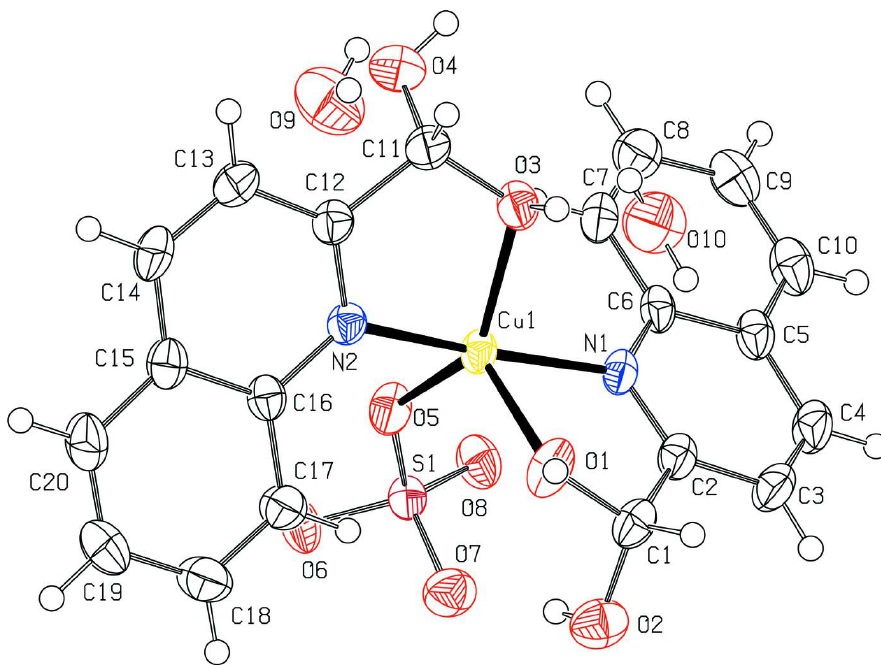
Figure 1 The molecular structure with displacement ellipsoids drawn at the 50%